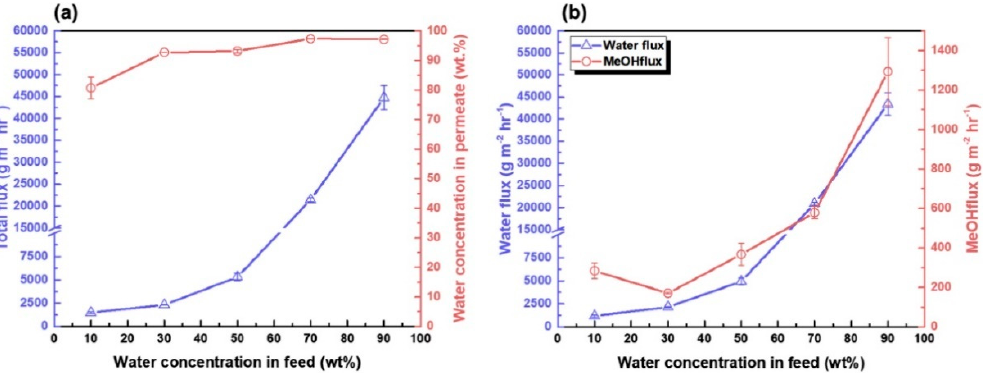
Figure 4. Effect of feed temperature on ( a ) cumulative flux and permeate water concentration in the separation of a 70/30 wt% MeOH/water using an Alg_rGO + GQD_3 membrane, ( b ) water and MeOH individual flux.